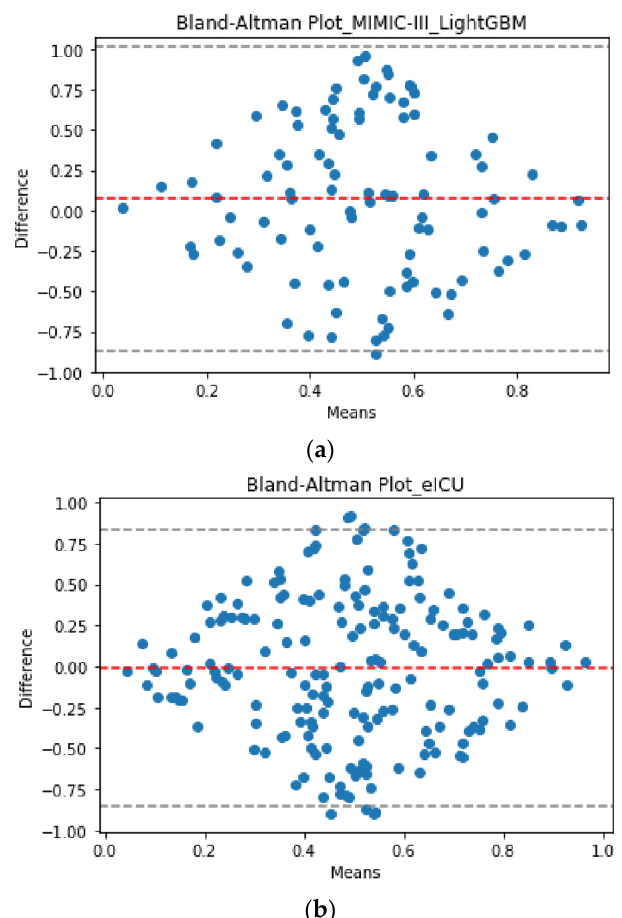
Figure 1. Bland–Altman plot for the truth vs. the predicted values of MV duration using LightGBM (the best validated model) in Scenario II (the best early scenario). ( a ) Development database; ( b ) validation database. The X- and Y-axes stand for the mean and the difference of the two measure- ments, respectively. Please note that the values shown in the Bland–Altman plot are normalized in the interval (0, 1) (i.e., values are scaled to have corresponding values between 0 and